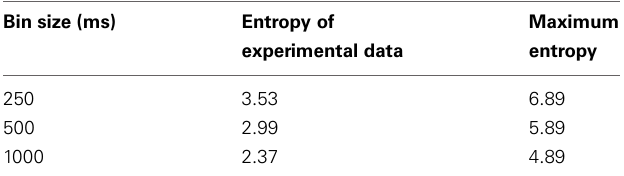
Table 5 | Maximum entropy and entropy of correct go-responses in Experiment